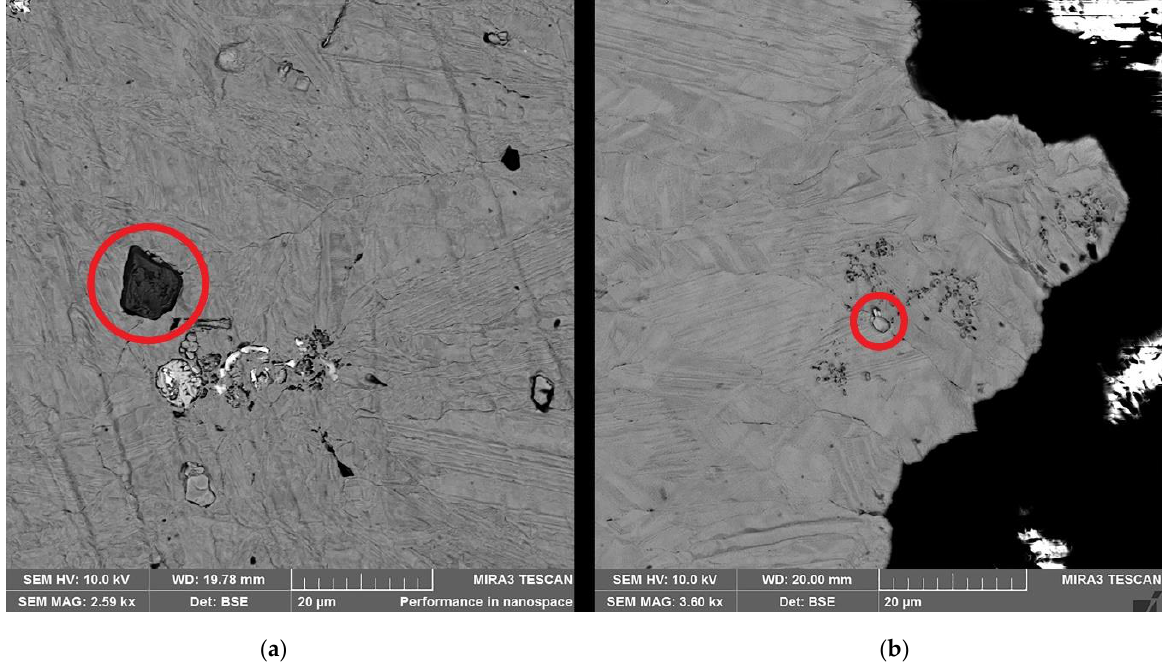
Figure 4. BSE micrographs of SB-8 ( a ) and SA-3 ( b ) cathodes. Ni-containing anode slime was found inside the cathode without nodulation ( a ), and a Cu-containing particle was found at the root of a small nodule ( b ). The particles of interest are highlighted with a red circle.